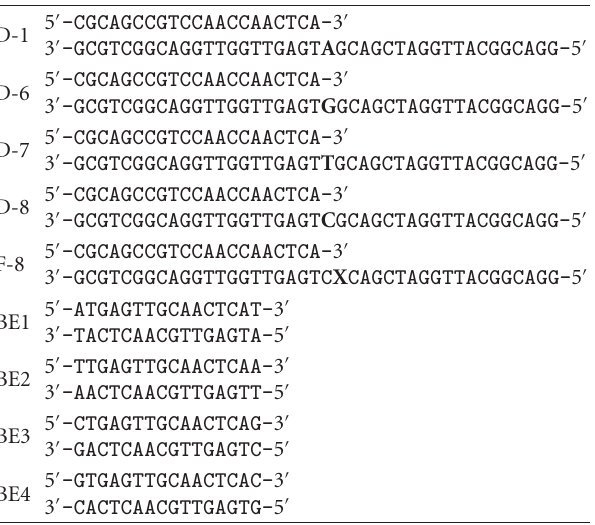
Table 1: Sequences of DNA substrates a